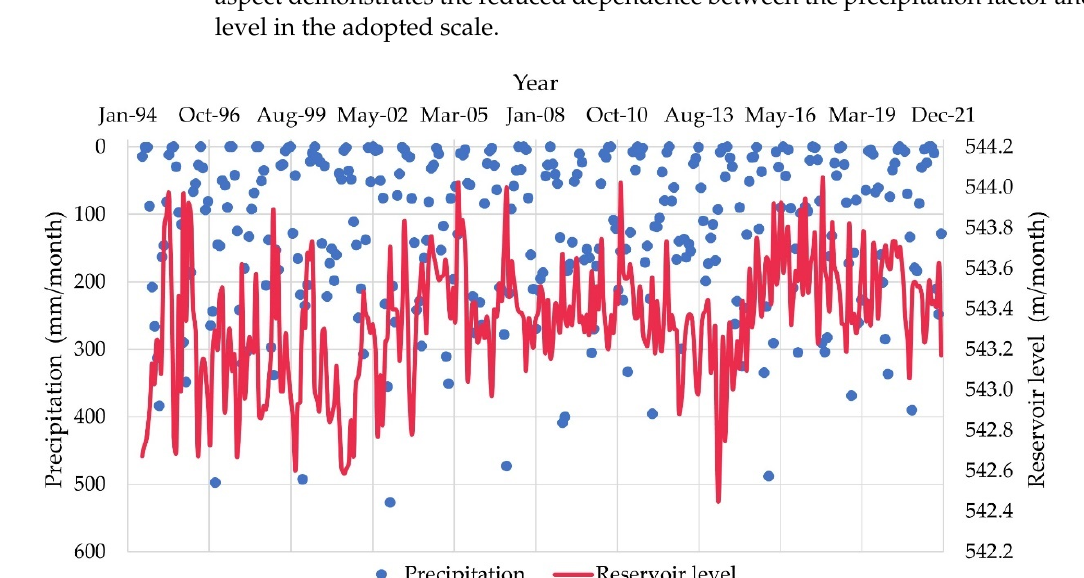
Figure 6. Average precipitation and reservoir levels at the Luiz Carlos Barreto de Carvalho and Porto Colombia HPPs (run-of-river).